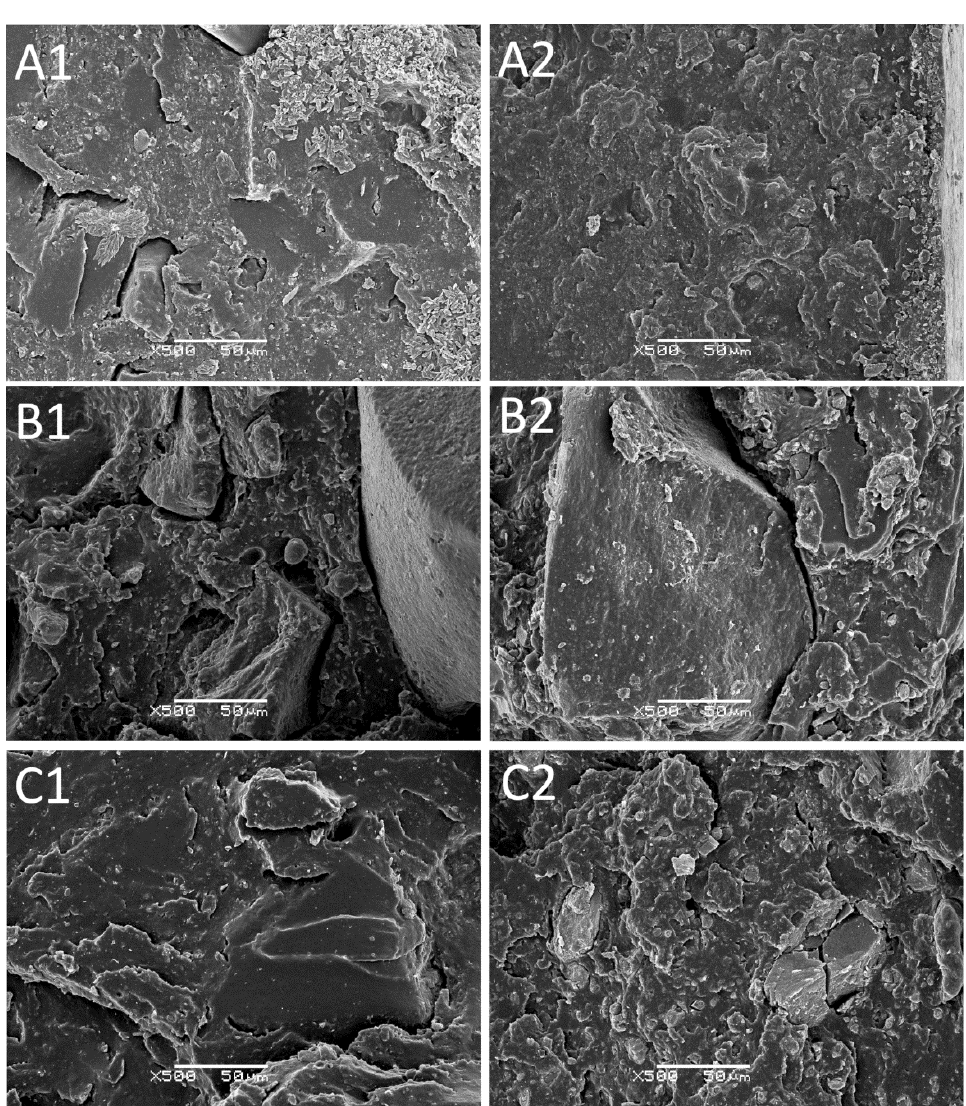
Figure 9. SEM images of samples: ( A1 ) GTR/NBR S/Si5 , ( A2 ) GTR/NBR S/Si30 , ( B1 ) GTR/NBR DCP/Si5 , ( B2 ) GTR/NBR DCP/Si30 , ( C1 ) GTR/NBR BIB/Si5 , ( C2 ) GTR/NBR BIB/Si30 (magnification ×500).